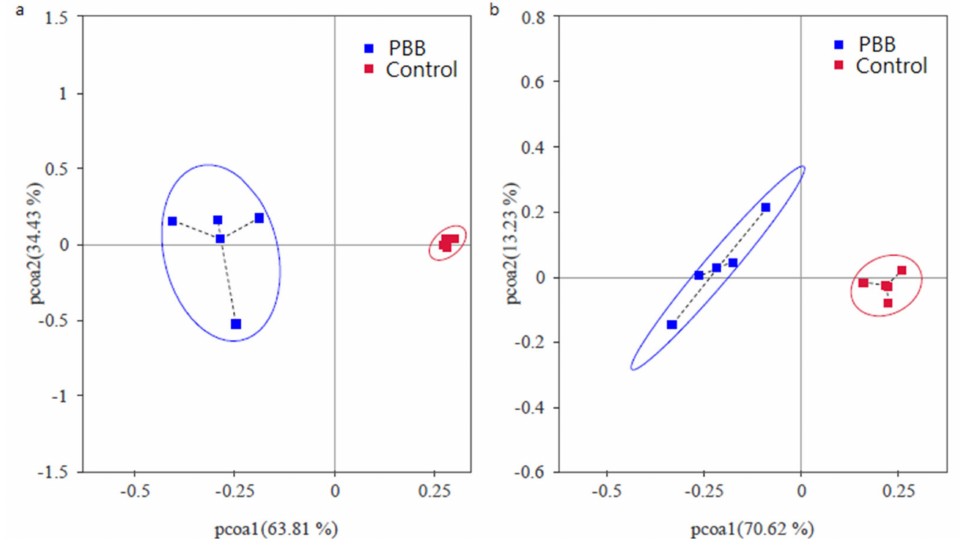
Figure 2. Principal coordinate analysis (PCoA) of soil fungal ( a ) and bacterial ( b ) communities based on Bray–Curtis distance. PBB represents 4% of PBB addition; control, with no PBB